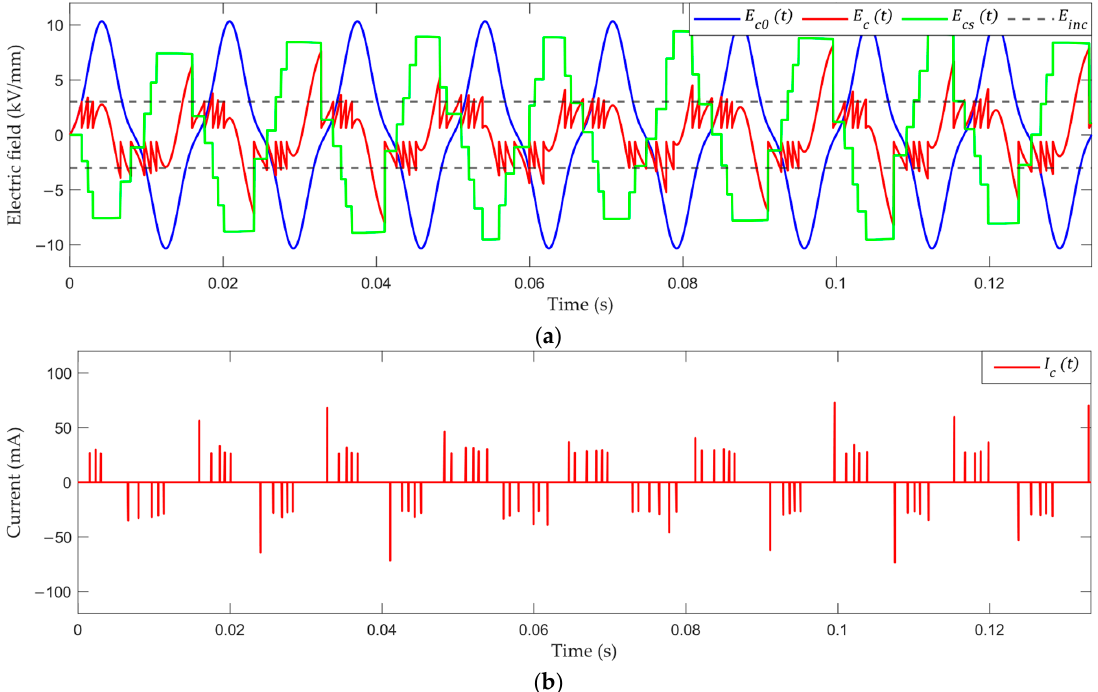
Figure 14. Simulated results for the case wherein a voltage distorted by the 3rd harmonic component with 𝜑 (cid:3035) = 180° and THD = 20% was applied: ( a ) electric fields over time; ( b ) PDs current pulses.